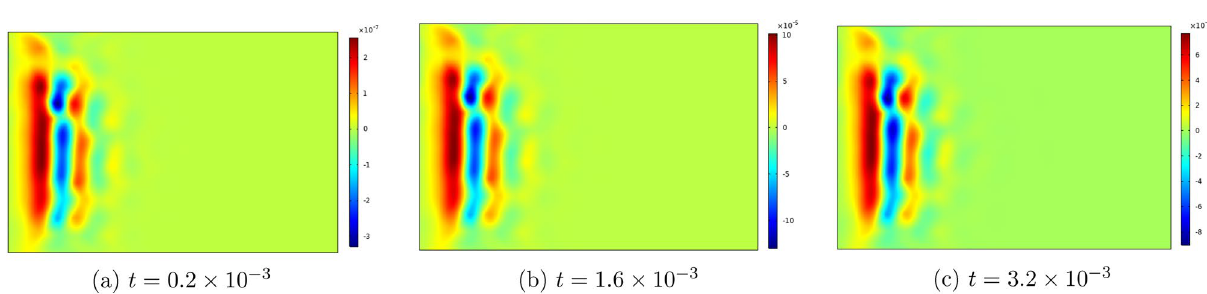
Figure 9. Top view of the distribution of v x in the slab at three consecutive time moments.